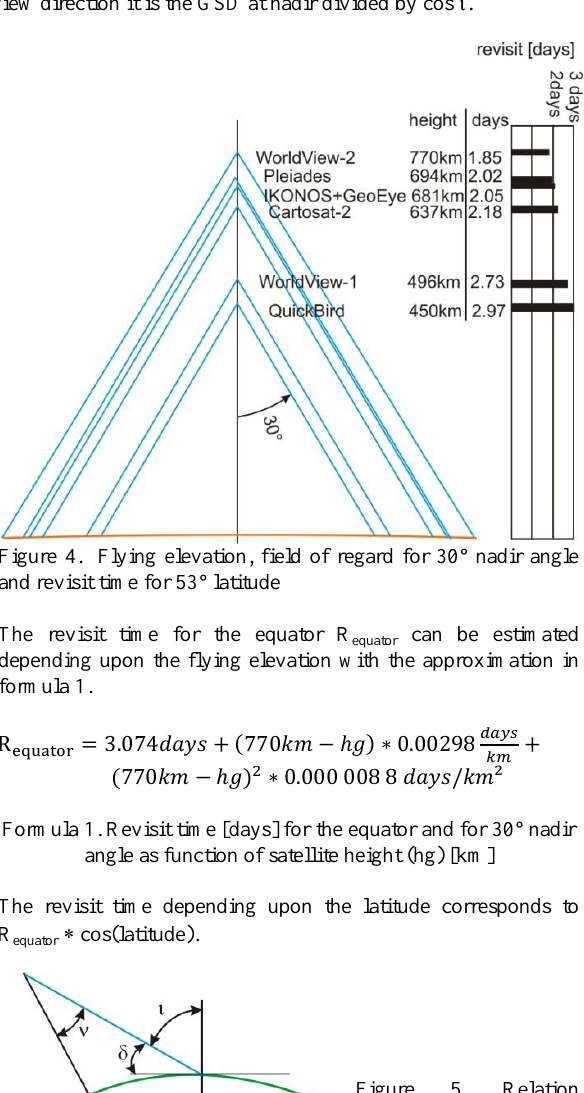
Figure 5. Relation between nadir angle  and incidence angle 